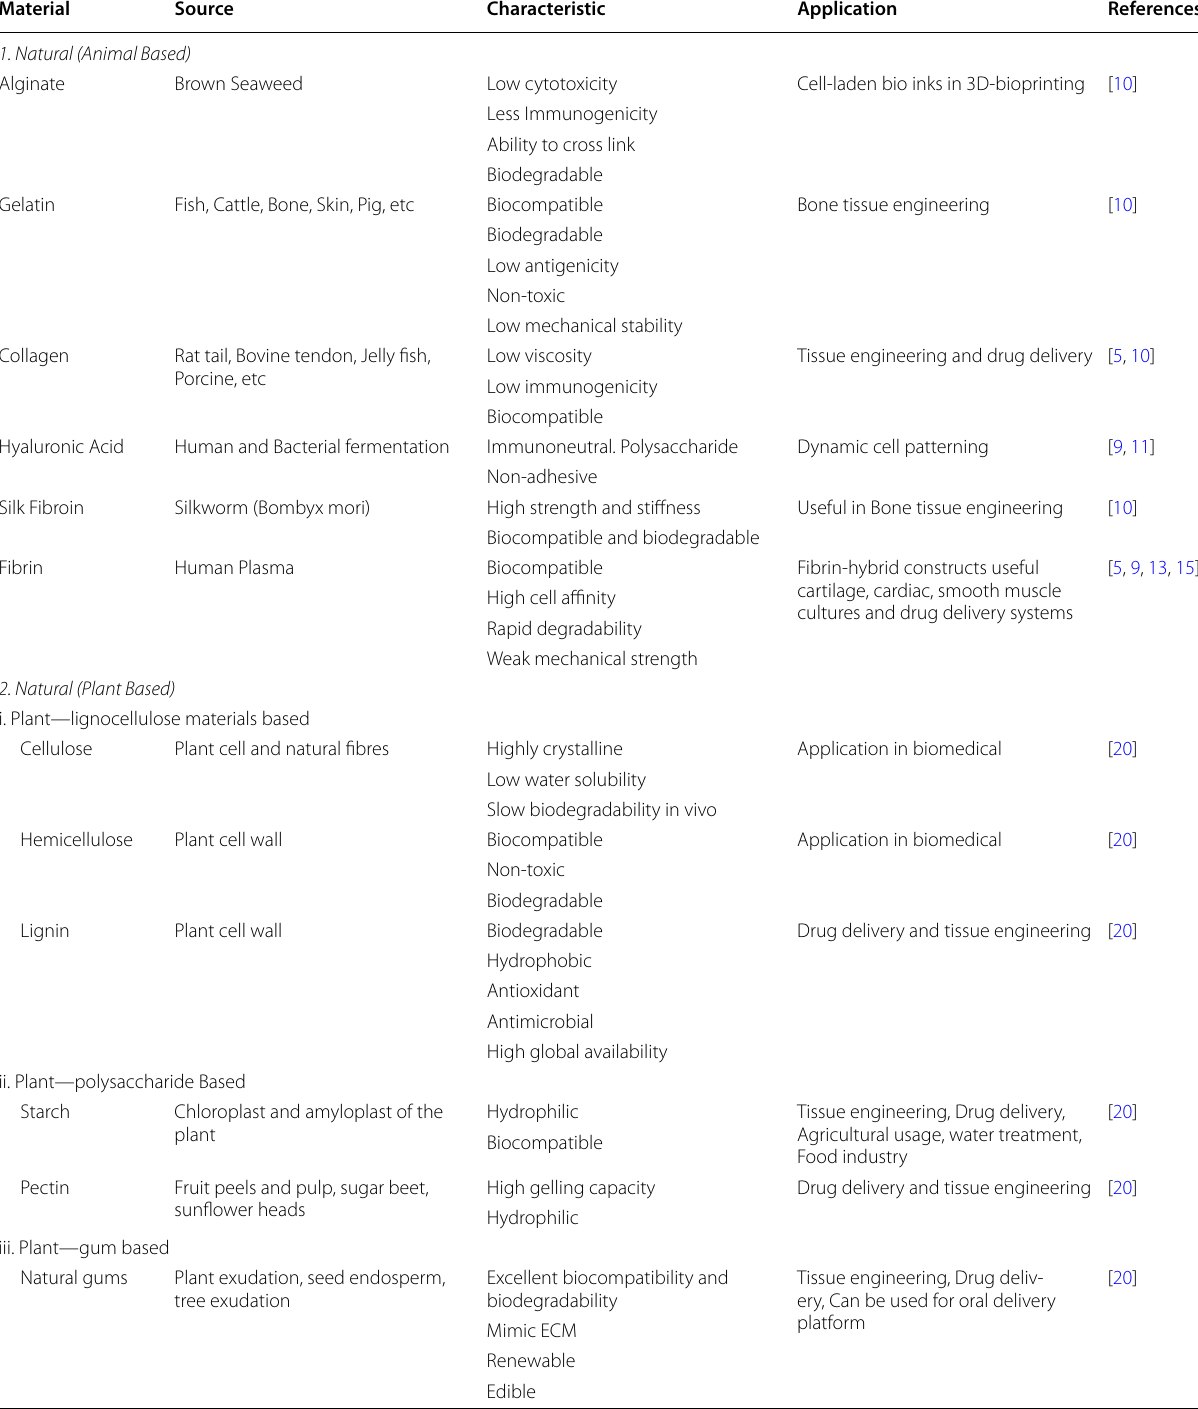
Table 1 Classification of natural and synthetic hydrogels: material, source, characteristic, application and reference